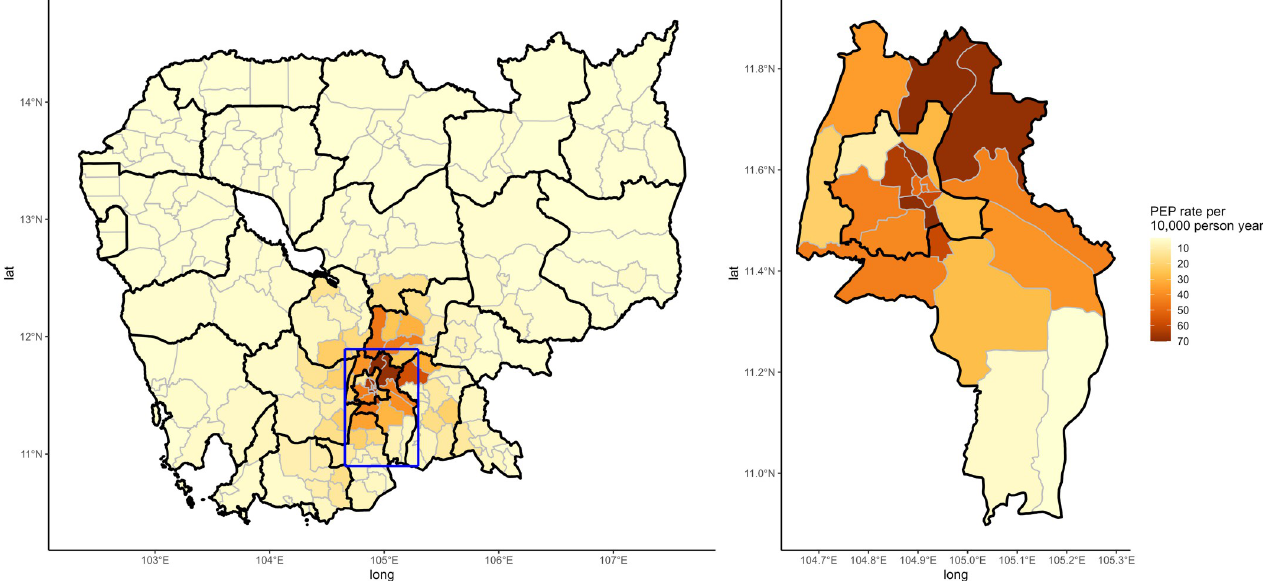
Fig 3. Observed average rates of PEP patients per district for the years 2013 to 2016. The inlet focuses on the provinces of Kandal and Phnom Penh where the majority of PEP patients at IPC come from. Bold lines represent provincial boundaries. Base map can be found at [45]. https://data.humdata.org/dataset/ cambodia-admin-level-0-international-boundaries. Details for the corresponding license can be found at: https://data.humdata.org/faqs/licenses.